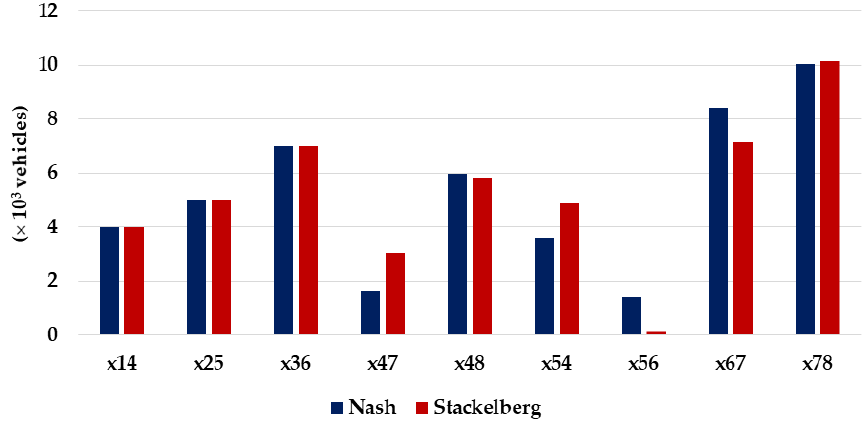
Figure 5. Comparison of traffic volume on individual links to road network for scenario #1.